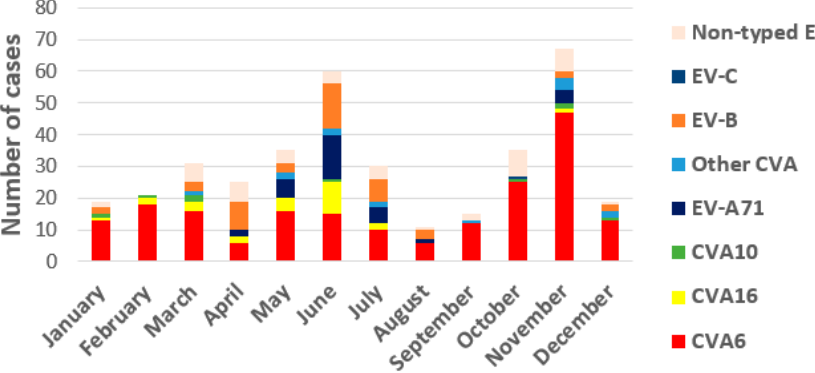
Figure 2. Seasonal circulation of prevalent EV-A, EV-B, EV-C types, and non-typed EV detected in the study. The types of samples taken were compared with the results of EV specie detection. In vesicular or cutaneous swabs, 124 out of 275 EV-As (45.1%) and only 6 out of 47